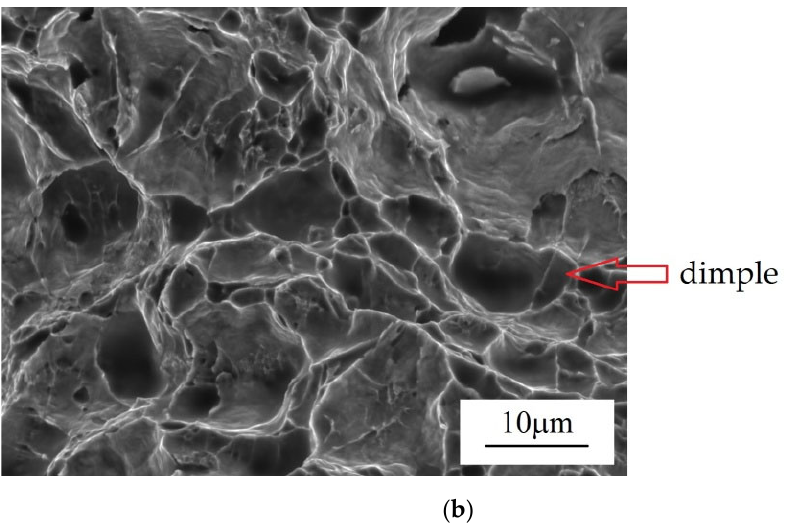
Figure 1. Void ‐ induced failure of metals: ( a ) Formation of a macroscopic crack due to void growth and coalescence in X52 steel [1]; ( b ) Fracture surface of a tensile S355 steel specimen and dimple microstructure resulting from void development (authors’ own study).